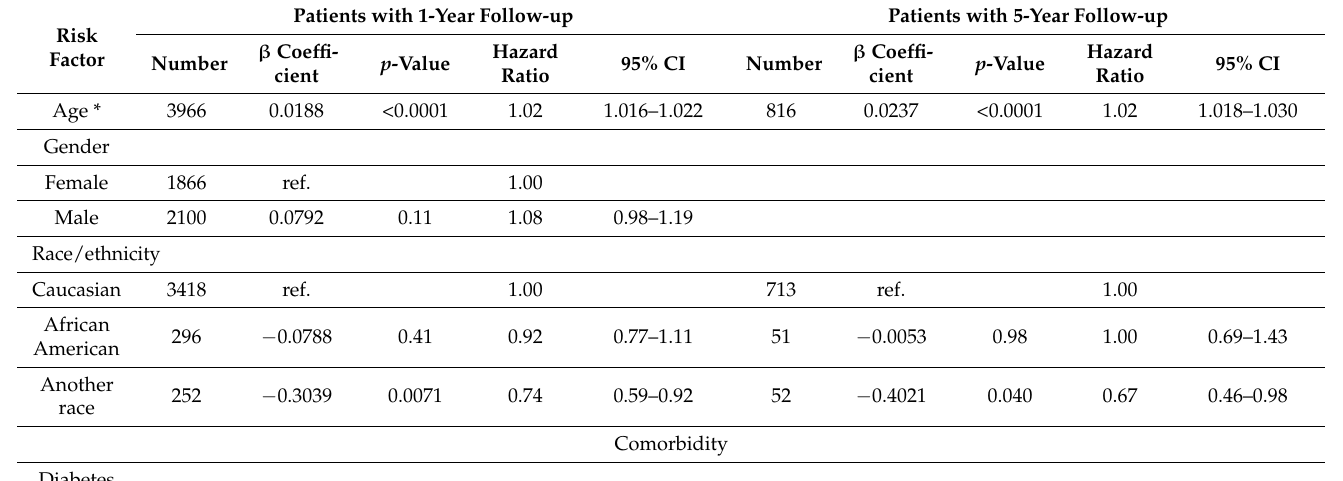
Table 2. Cox proportional regression coefficients and hazard ratios for AS patients with 1-year and 5-year